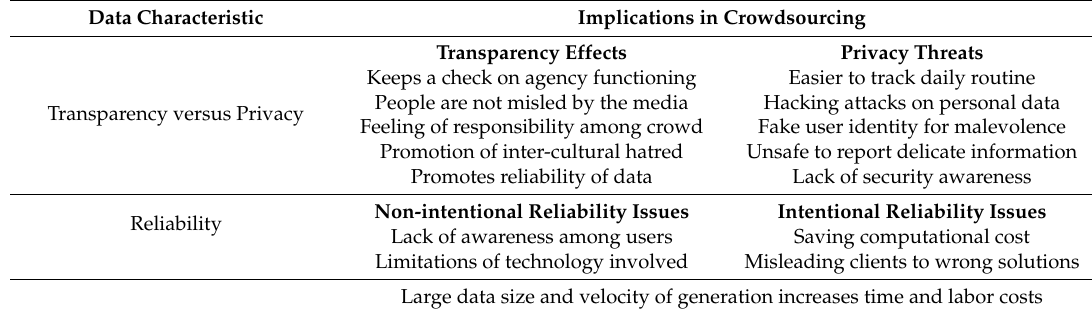
headings: (1) Transparency versus Privacy; (2) Reliability threats and (3) Size, Variety and Granularity of data. Table 3 encapsulates the major data characteristics that affect crowdsourcing. Table 3. Data characteristics affecting the feasibility of